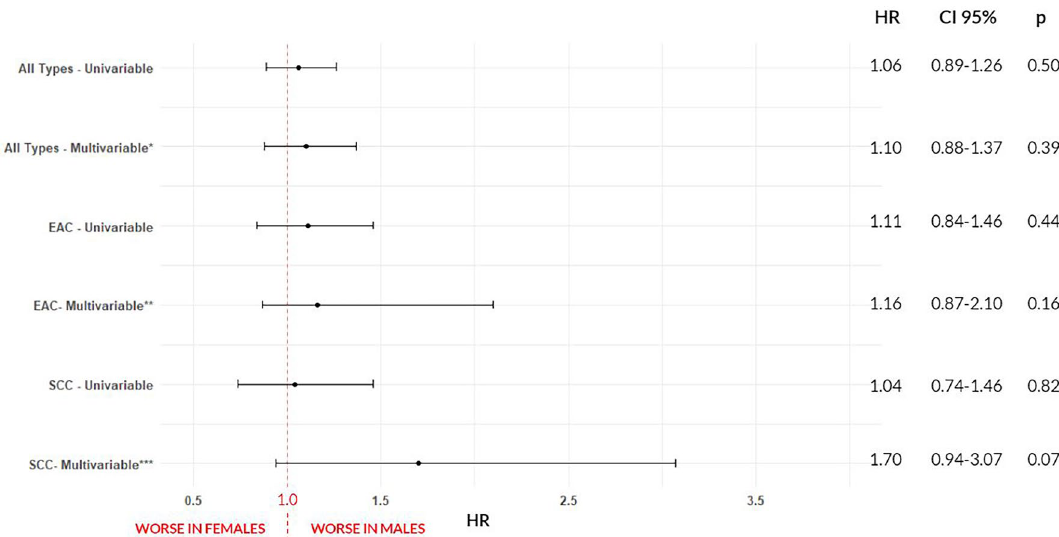
Figure 3. Forest plot of sex differences in survival for esophageal cancer (all types), esophageal adenocarcinoma (EAC) and squamous cell carcinoma (SCC). Univariable and multivariable cox models represented, UH Seidman Cancer Center Database (2005–2020). *Adjusted for: age at diagnosis, race, ethnicity, histology, obesity, Barret’s, gastrectomy, gastritis, gastroesophageal reflux, chemotherapy, surgery and radiotherapy. **Adjusted for: age at diagnosis, smoking status, obesity, Barret’s, alcoholism, achalasia, gastrectomy, gastritis, gastroesophageal reflux, h.pilory, chemotherapy, surgery and radiotherapy. ***Adjusted for: race, Barret’s, gastritis, gastroesophageal reflux, h.pilory, radiotherapy, surgery, smoking status and alcoholism.